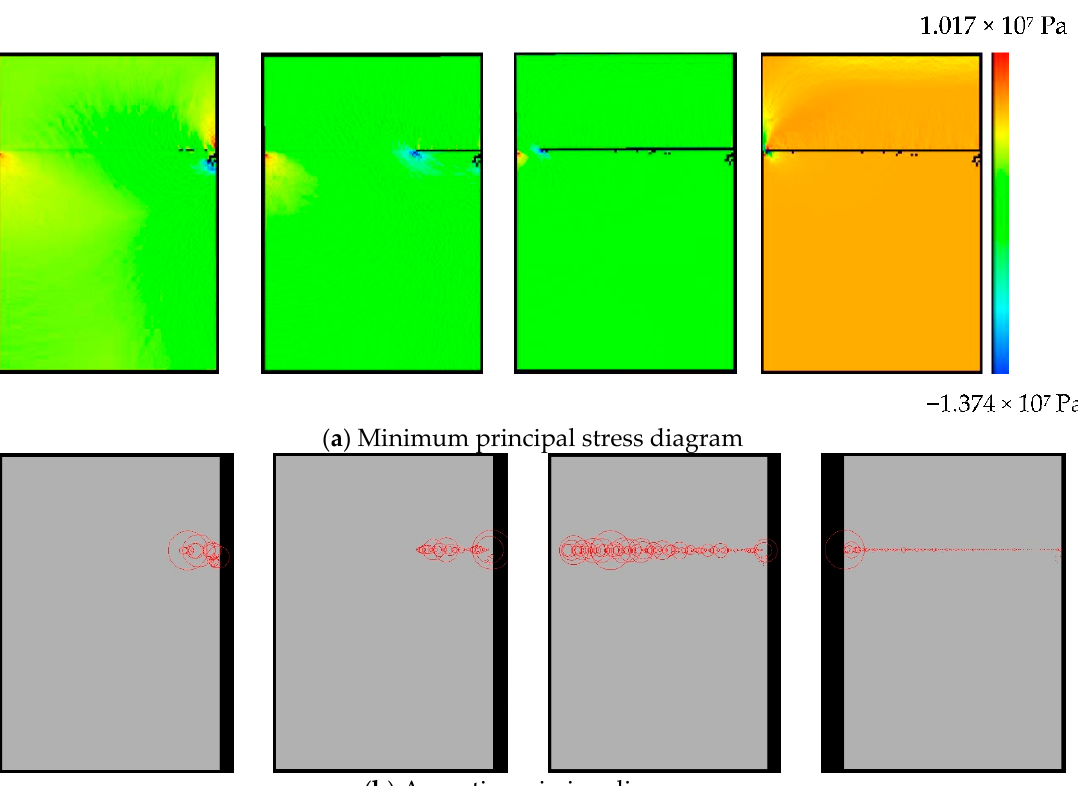
Figure 24. Failure process of specimen with geotextile interface.